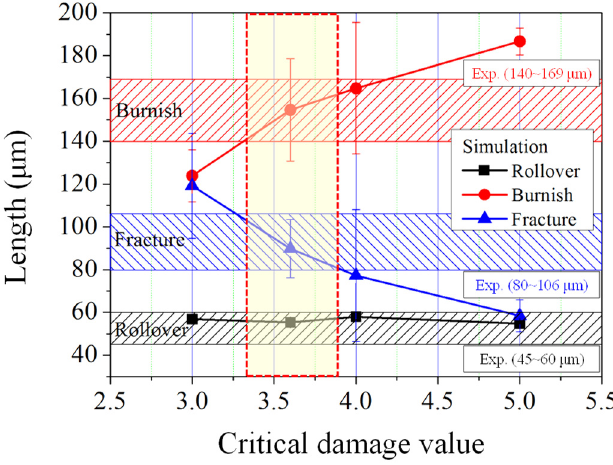
Figure 7. Comparisons of lengths in slitting plane obtained from FE analysis and experiment according to the critical damage value.